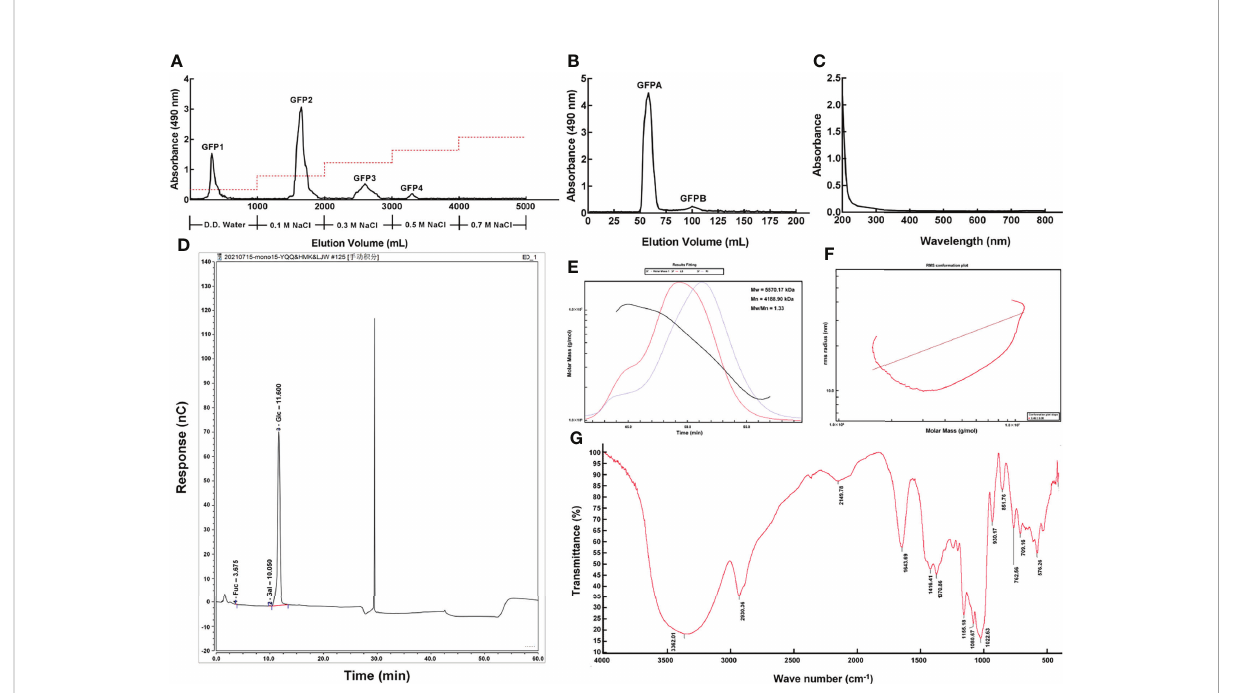
FIGURE 1 Puri fi cation and primary structural characterization of GFPA. GFPA was puri fi ed using (A) a DEAE-52 anion-exchange column and (B) a Chromdex 200 prep grade column. GFPA characterization and glycosyl composition were determined based on (C) UV spectra, (D) monosaccharide component chromatograms, (E) homogeneity and molecular weight, (F) molecular con fi guration analysis and (G) Fourier-transform infrared